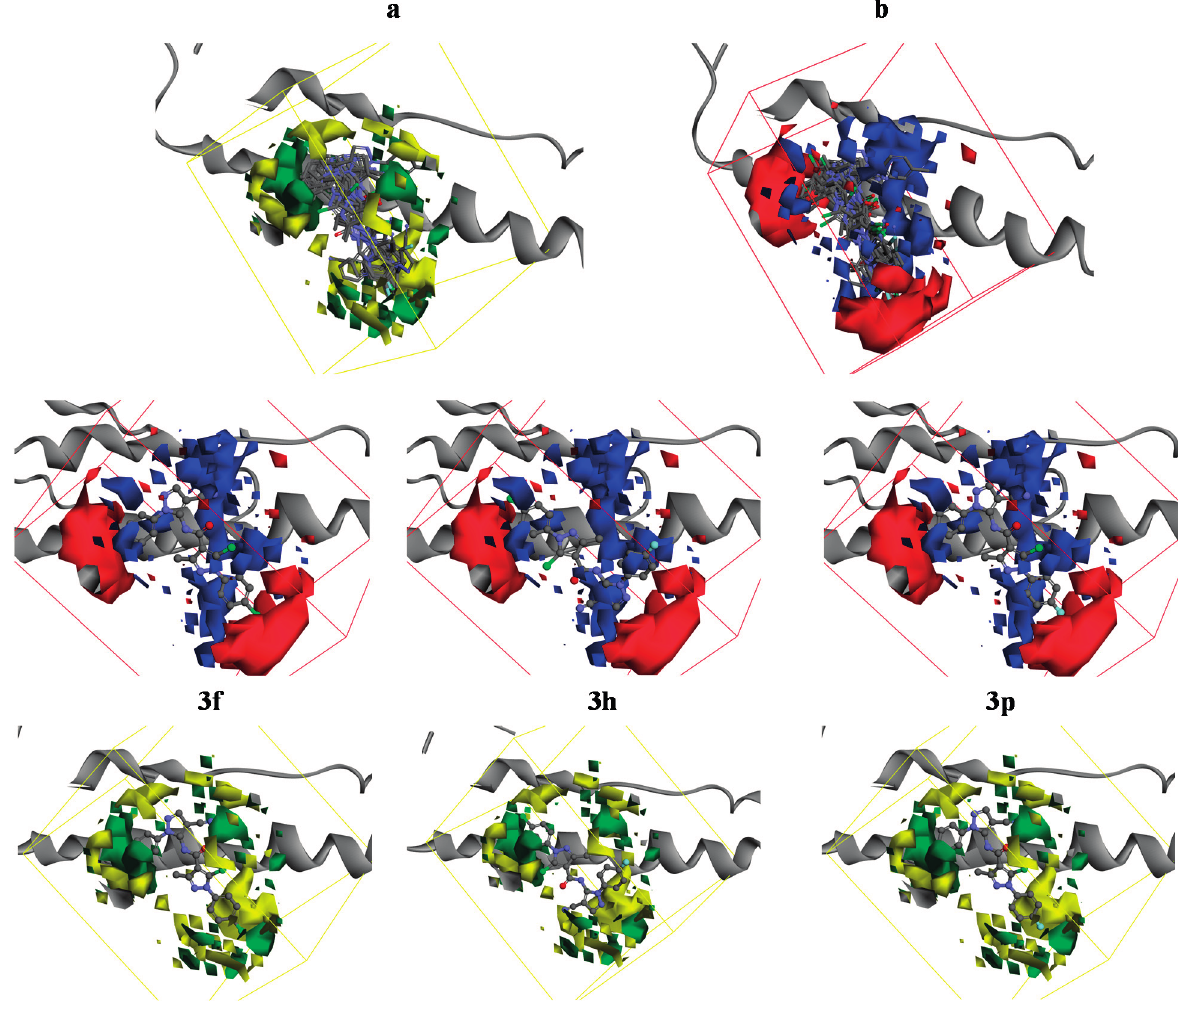
Figure 5. 3D-QSAR of pyrazole amide derivatives for TMV PC (PDB: 2OM3). ( a ) 3D-QSAR model coefficients on van der Waals grids. Green represents positive coefficients; yellow represents negative coefficients; ( b ) 3D-QSAR model coefficients on electrostatic potential grids. Blue represents positive coefficients; red represents negative